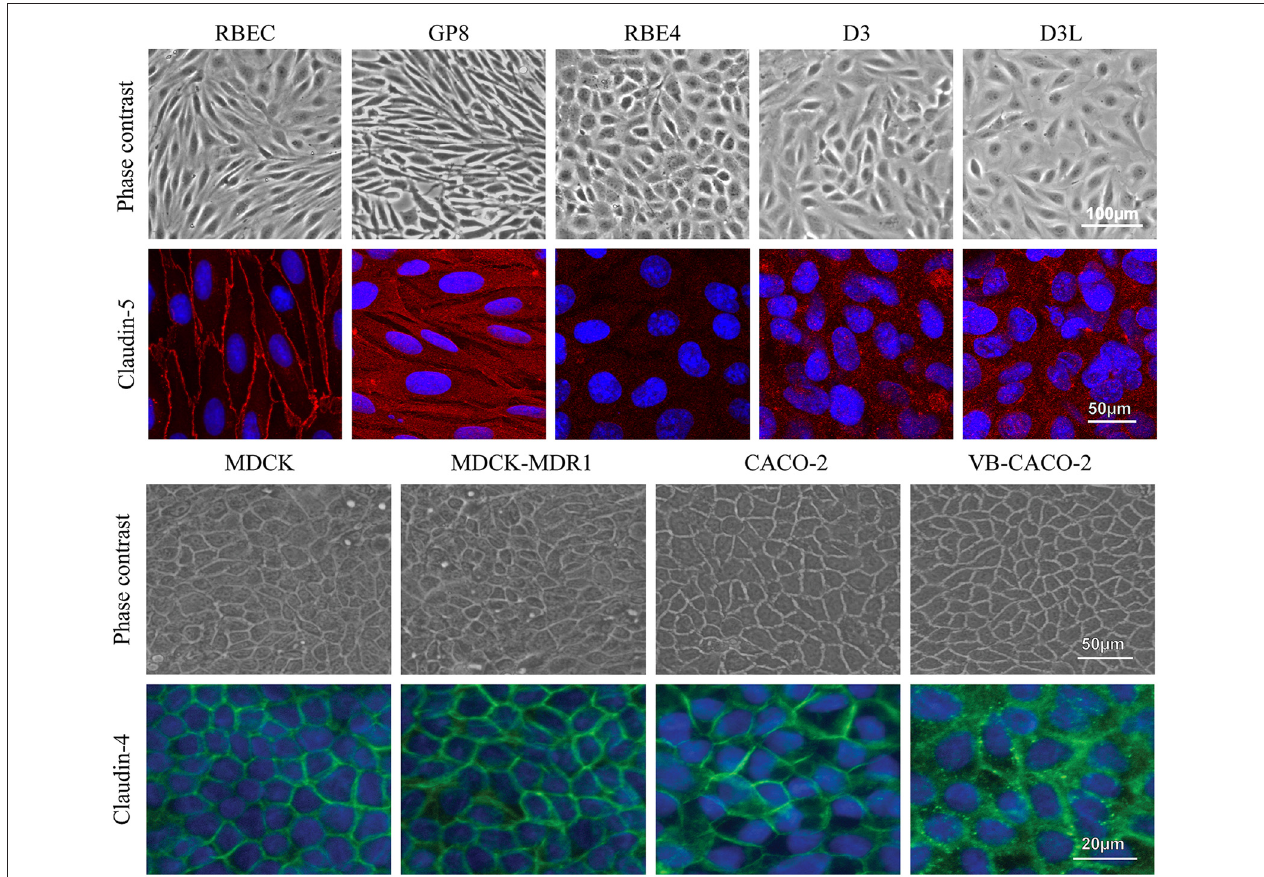
FIGURE 9 | Different types of brain endothelial and epithelial cell cultures examined by phase contrast microscopy and stained for tight junction proteins CLDN5 (red) and CLDN4 (green), and cell nucleus (blue). The CLDN5 immunostaining was well visible on the cell border of RBEC cells, while it was very weak or undetectable in the brain endothelial cell lines. MDCK and Caco-2 epithelial cells showed an intense staining for CLDN4. Bars: 50 and 100 µ m (phase contrast pictures); 20 and 50 µ m (immunostaining pictures).